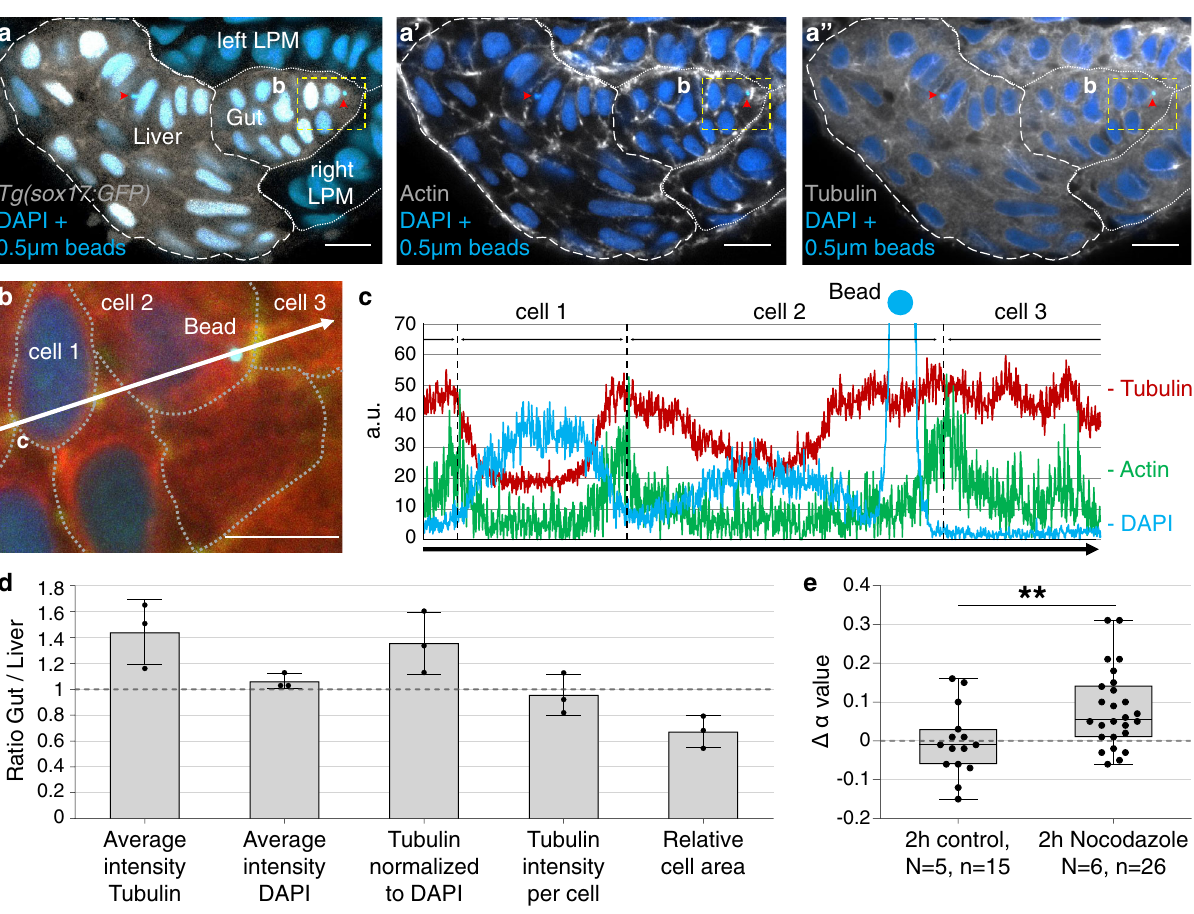
Fig. 4 Microtubules surround injected nanoparticles and their concentration is increased in gut progenitors. a – a ” Transverse section of a 30 hpf tg(sox17:GFP) embryo microinjected with 0.5 µ m fl uorescent polystyrene beads (light blue dots next to red arrowheads) showing Phalloidin staining of actin fi laments (gray in ( a ’ )) and β -tubulin staining to visualize microtubules (gray in ( a ” )). Fluorescent emission of microinjected beads and nuclear DAPI occurs at similar wavelengths; beads are detected by size and high signal intensity. Scale bar: 10 µ m. b Magni fi cation of cellular bead location (yellow dashed rectangle in ( a – a ” )). Cell borders are outlined based on the presence of cortical actin (dashed lines). Scale bar: 20 µ m. c Intensity pro fi le of actin, tubulin, and DAPI along the white arrow in ( b ). The high peak in the DAPI channel indicates bead position. d Ratio of tubulin levels between gut and liver determined from tissue volumes with a typical linear dimension of 20 µ m (see “ Methods ” and Supplementary Fig. 5). The average intensity represents the signal intensity normalized to tissue area (tubulin) or nuclear area (DAPI) for each optical section. Tubulin intensity per cell is calculated by normalizing the average Tubulin intensity to the nuclei number. The relative cell area was obtained by normalizing the volume of the respective tissue to nuclei number. Error bars represent one standard deviation, number of analyzed embryos = 3. e α -value changes after 2 h of 2 µ M Nocodazole treatment (green; mean + SD = 0.082 ± 0.1) and in DMSO controls (blue; mean + SD = − 0.004 ± 0.09). N = number of embryos, n = number of measured nanoparticles; P value calculated using unpaired equal variance two-tailed t test; ** P =